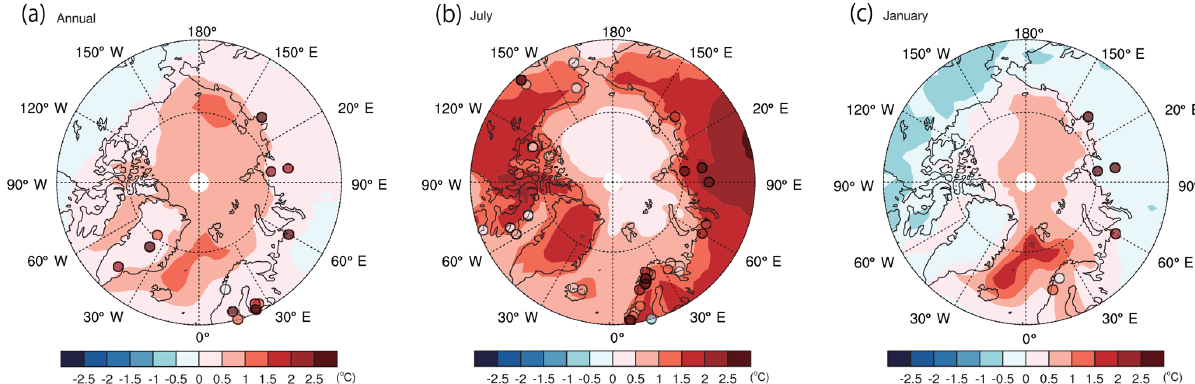
Figure 4. Surface air temperature anomaly ( ◦ C) for (cid:49) MH from the simulations (shading) and reconstruction (solid circles): (a) annual mean; (b) July; and (c) January. The reconstruction data are taken from Sundqvist et al. (2010). The mean of all 10 models listed in Table 2 was